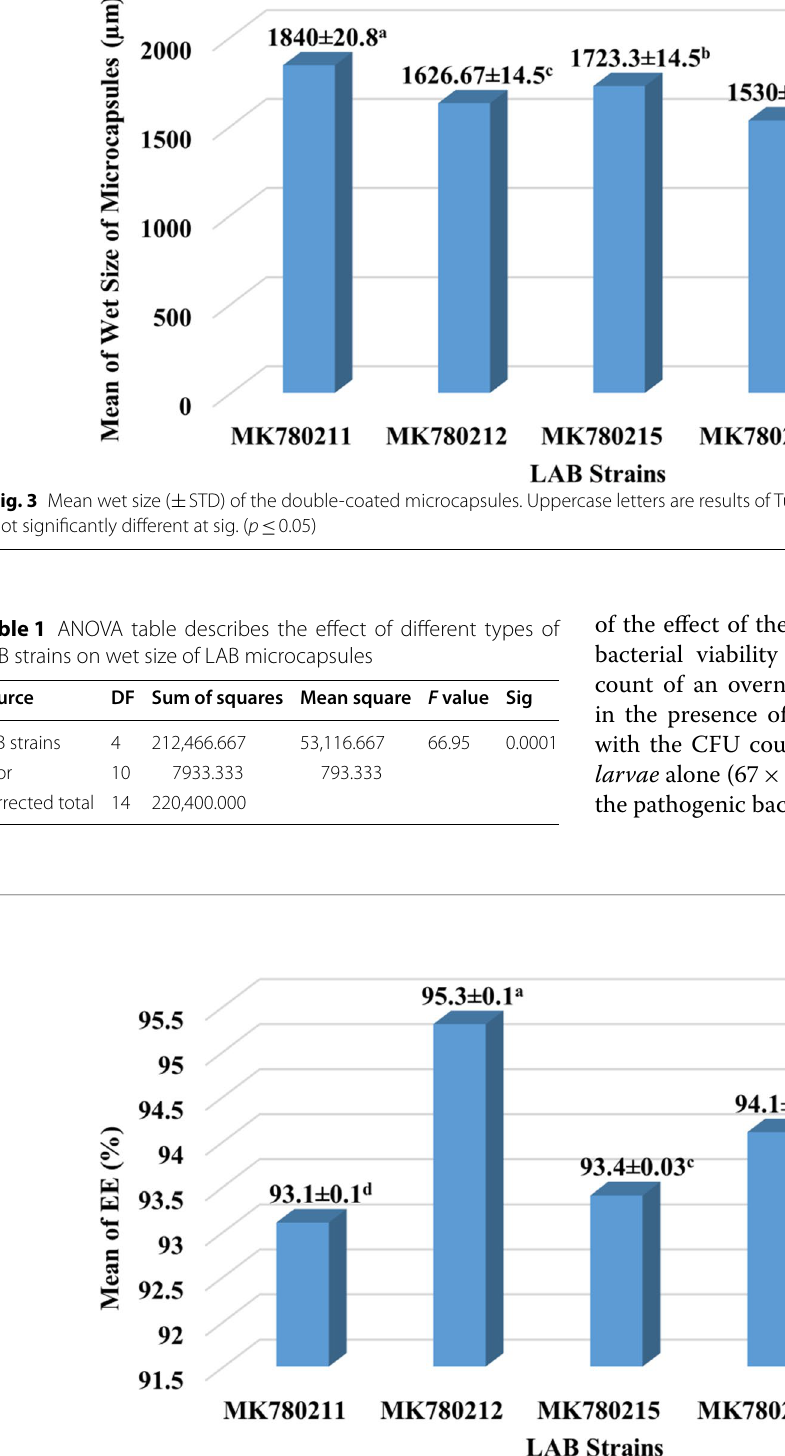
Fig. 4 The relation between bacterial strain types and mean encapsulation efficiency ( with the same letter are not significantly different at sig. ( p